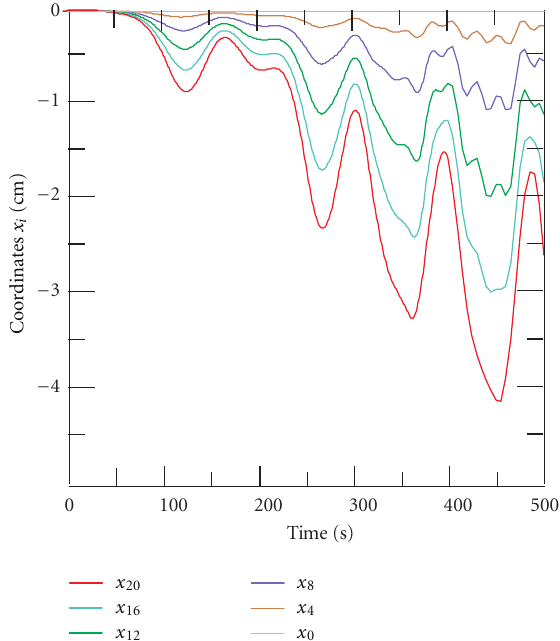
Figure 13: General coordinates x i versus time.